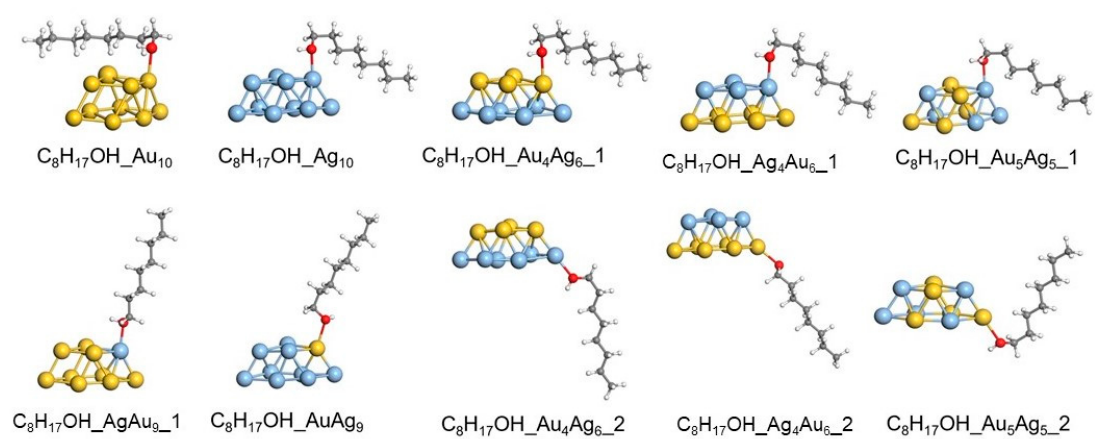
Figure 8. Optimized structures of C 8 H 17 OH_Au x Ag y (x + y = 10) complexes. The energy of octanol adsorption on Au x Ag y (x + y = 10) was calculated by Equations (3) and (4), and the results are presented in Table 4. Firstly, we consider the results ob ‐ tained for the neutral clusters. According to the calculation results, 1 ‐ octanol was better adsorbed on Au 10 than on Ag 10 monometallic clusters: the binding energy of C 8 H 17 OH with a silver atom in Ag 10 was 13 kJ/mol lower than with a gold atom having the same coordination number in Au 10 . However, the introduction of even one silver atom into the gold 10 ‐ atom cluster (see the results for AgAu 9 in Figure 8) model increased the binding energy of the adsorption of alcohol on the Ag heteroatom up to 47 kJ/mol. In contrast, the